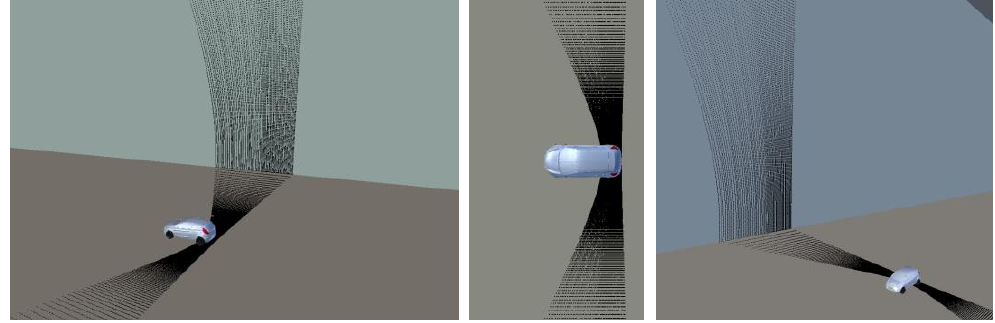
Figure 7. A simulated scan on the ground and aside facade.